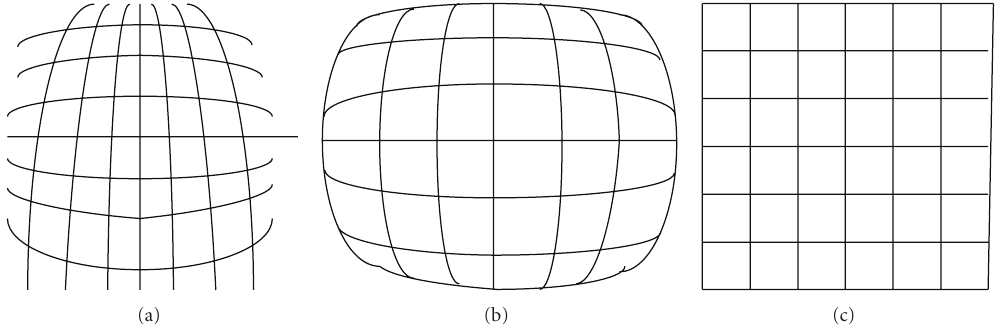
Figure 7: Illustrations for (a) the real scene image, (b) the distorted image, and (c) the desired